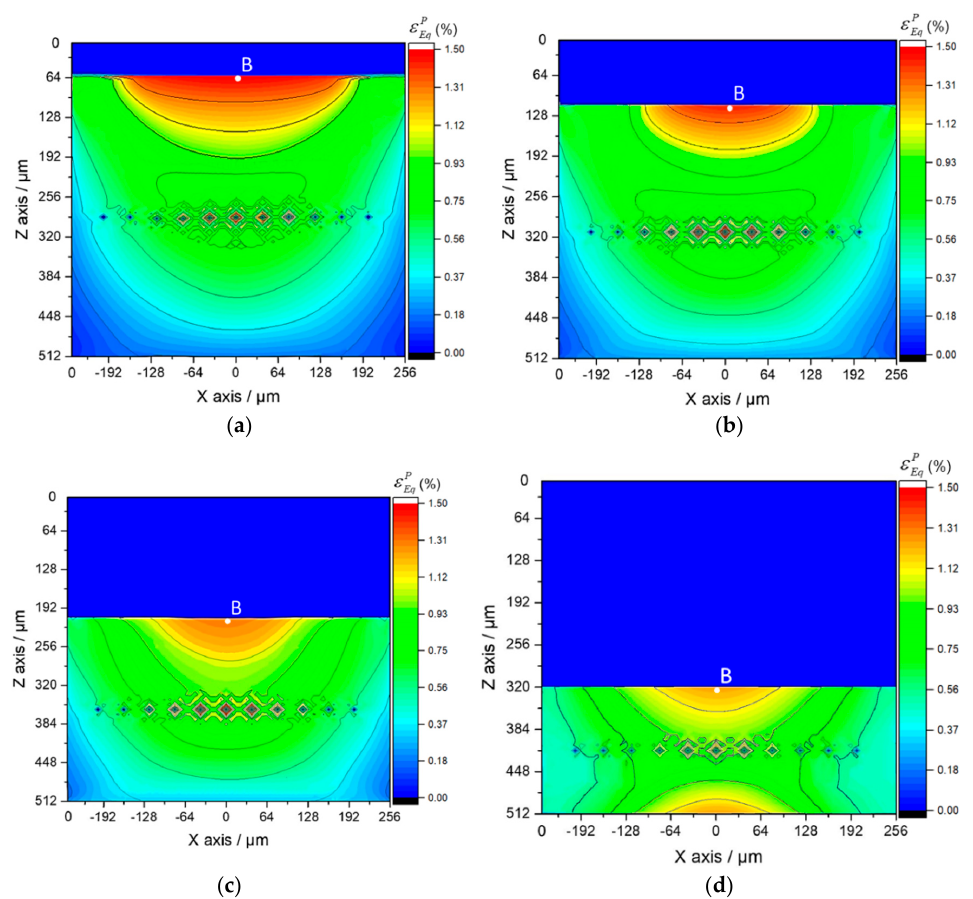
Figure 25. Equivalent plastic strain fields in cross section XOZ with varying volume fractions of Ti: